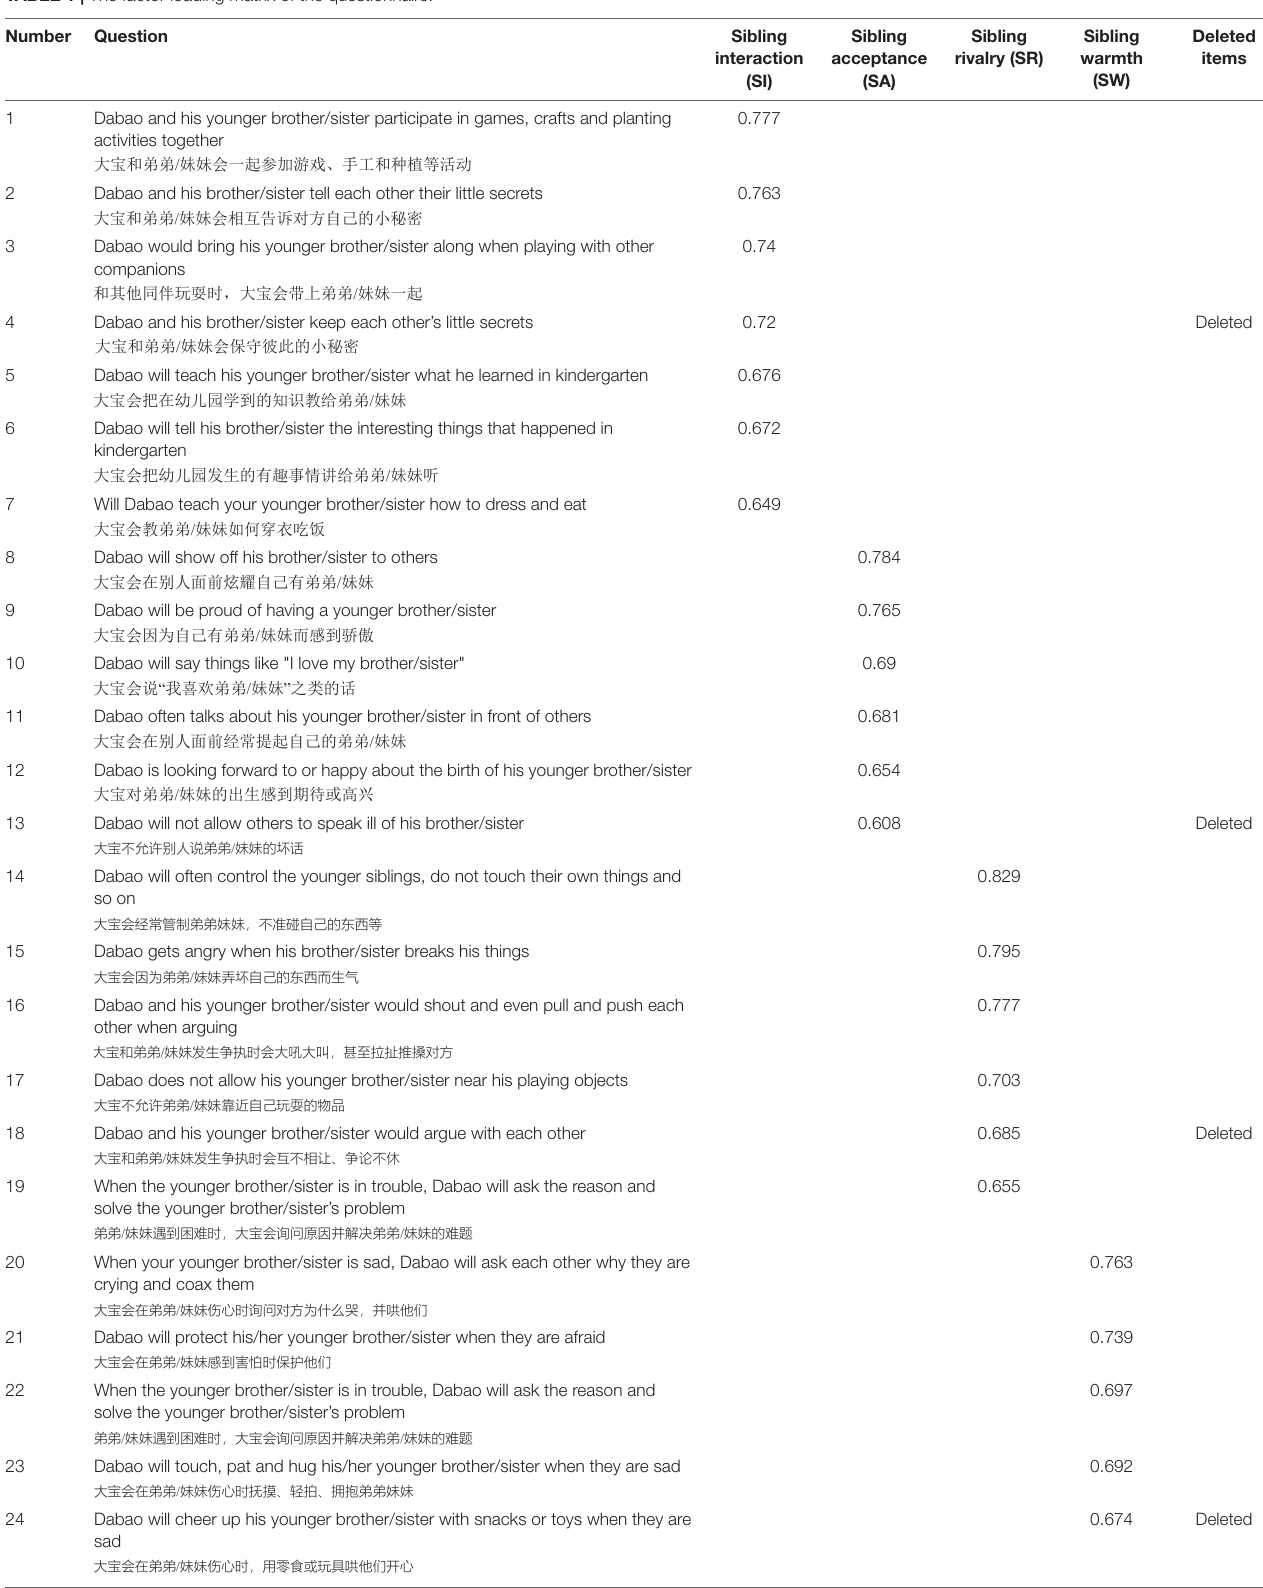
TABLE 1 | The factor loading matrix of the